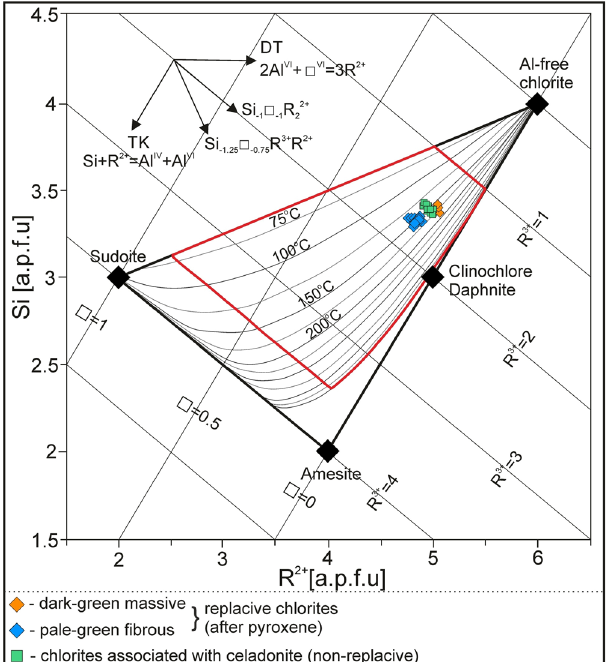
Figure 11. Distribution of temperatures obtained for replacive chlorites and chlorites associated with celadonite (non-replacive) within T –R 2+ –Si diagram 45 .